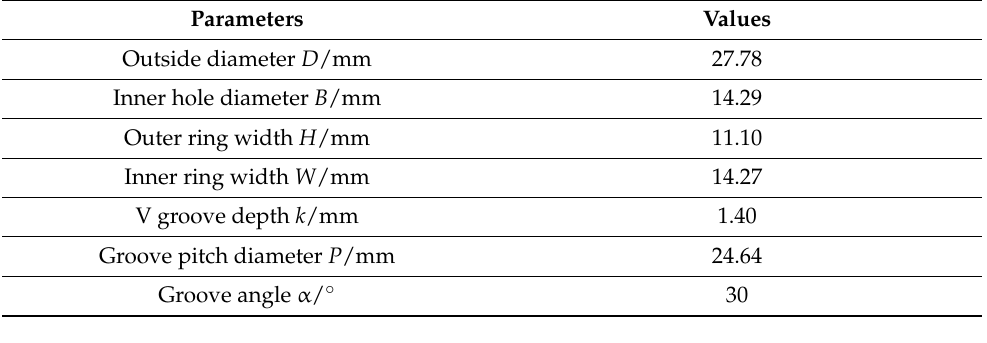
Table 1. Main parameters of the MS14101-9 bearing.